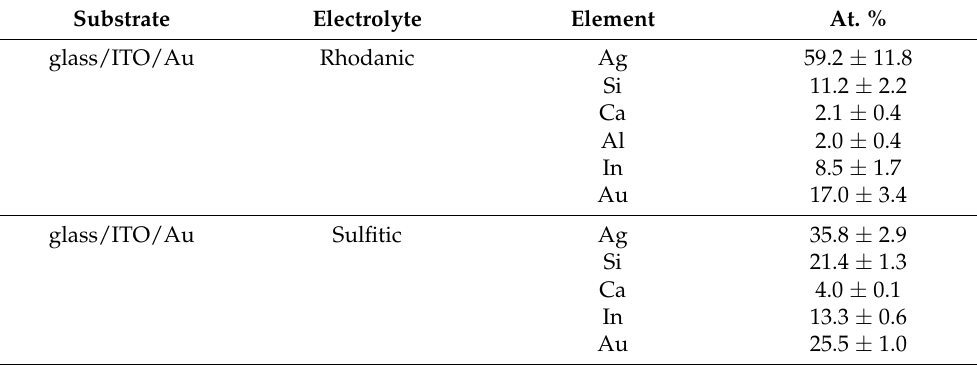
Table 1. EDX data of the Ag film obtained using rhodanic and sulfitic electrolytes. Substrate Electrolyte Element At. %